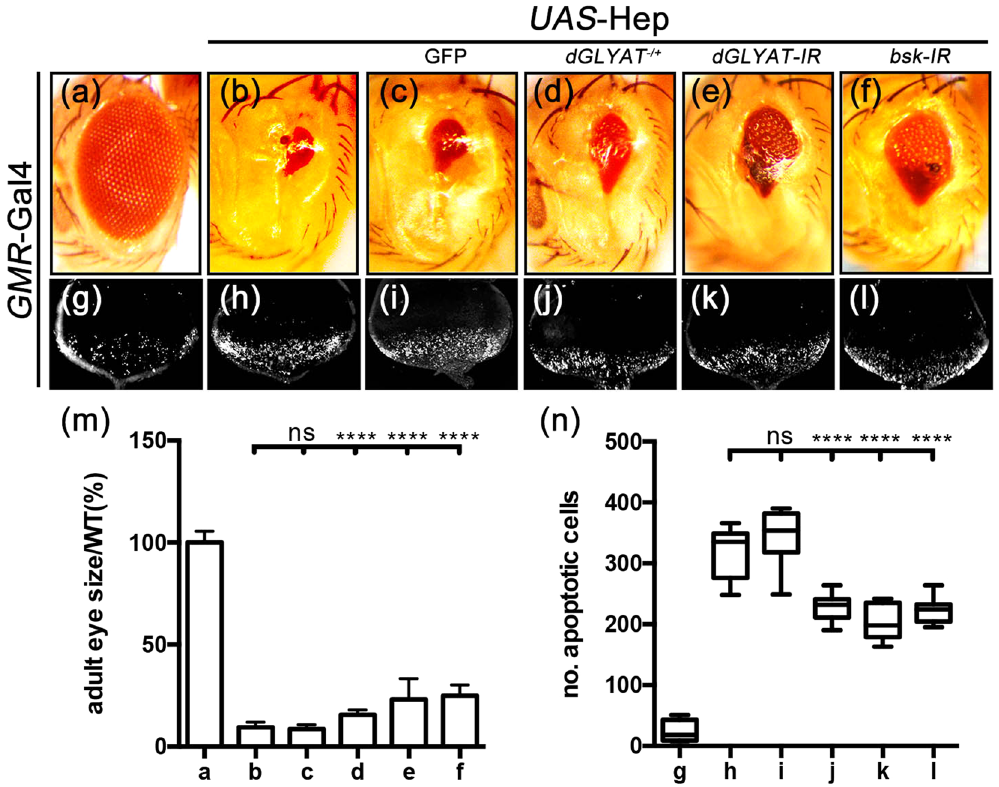
Figure 2. Loss of dGLYAT suppresses ectopic Hep-induced cell death in eye development. Light micrographs of Drosophila adult eyes ( a–f ) and fluorescent micrographs of third instar eyes discs ( g–l ) are shown. Compared with the GMR -Gal4 controls ( a , g ), GMR > Hep induces a small eye phenotype in adults ( b ) and extensive cell death in 3 rd instar larval eye discs ( h ). Both phenotypes are suppressed by mutation ( d , j ) or RNAi-mediated depletion ( e , k ) of dGLYAT , but remains unaffected by expressing GFP ( c , i ). Expression of bsk-IR serves as a positive control ( f , l ). ( m ) Statistics of eye sizes shown in ( a – e ) (a, n = 12; b, n = 51; c, n = 29; d, n = 16; e, n = 26; f, n = 20). ( n ) Statistics of AO-positive cell numbers shown in ( g – l ) (g, n = 5; h, n = 8; i, n = 8; j, n = 11; k, n = 8; l, n = 8). n.s., P > 0.05; **** P < 0.0001.